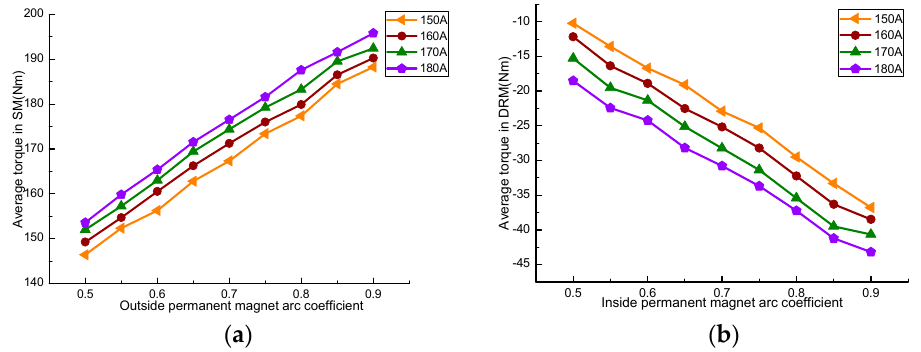
Figure 8. Variation of average torque in SM and DRM with permanent magnet pole arc coefficient: ( a ) SM; ( b ) DRM.